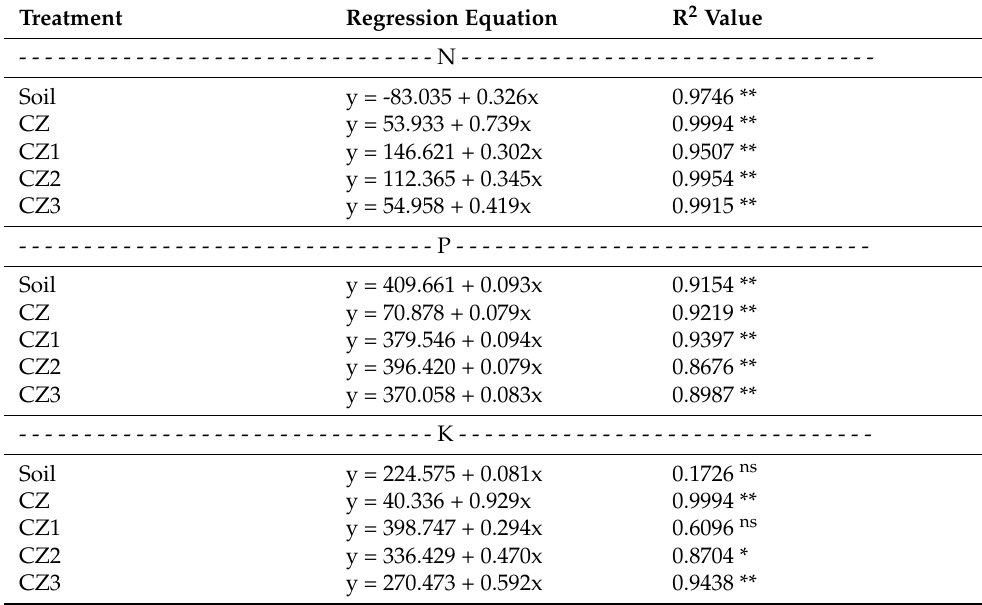
Table 11. Linear relationships between the added nitrogen, phosphorus, and potassium concentra- tions and the amounts of nitrogen, phosphorus, and potassium adsorbed.